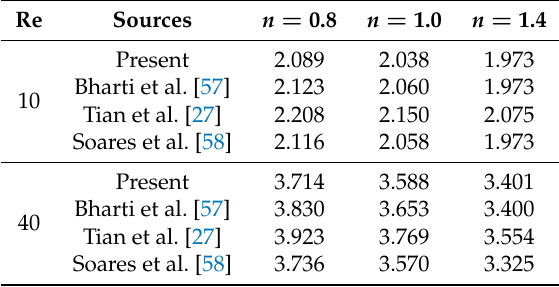
Table 3. Averaged Nusselt number ( Nu ) for forced convection heat transfer from a stationary cylinder to power-law fluids at Pr =